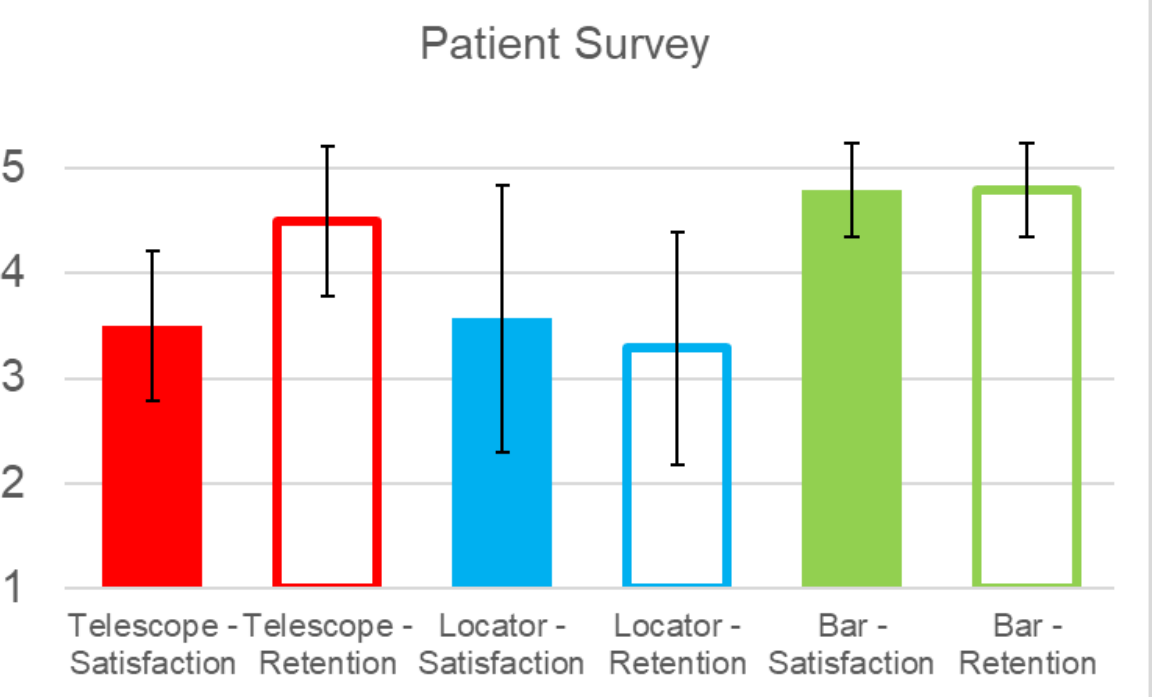
Figure 6. Patient satisfaction with respect to overall treatment and retention of implant-supported overdentures employing telescopic crowns, Locator-type attachments, and bars as retentive devices. Satisfaction could be rated on a scale from 1 (low) to 5 (high). Table 2. Results ( p -value) of pairwise comparisons (Kruskal–Wallis rank sum test; Bonferroni correc- tion) between patient satisfaction with respect to overall treatment and retention of implant-supported overdentures employing telescopic crowns, Locator-type attachments, and bars as retentive devices.